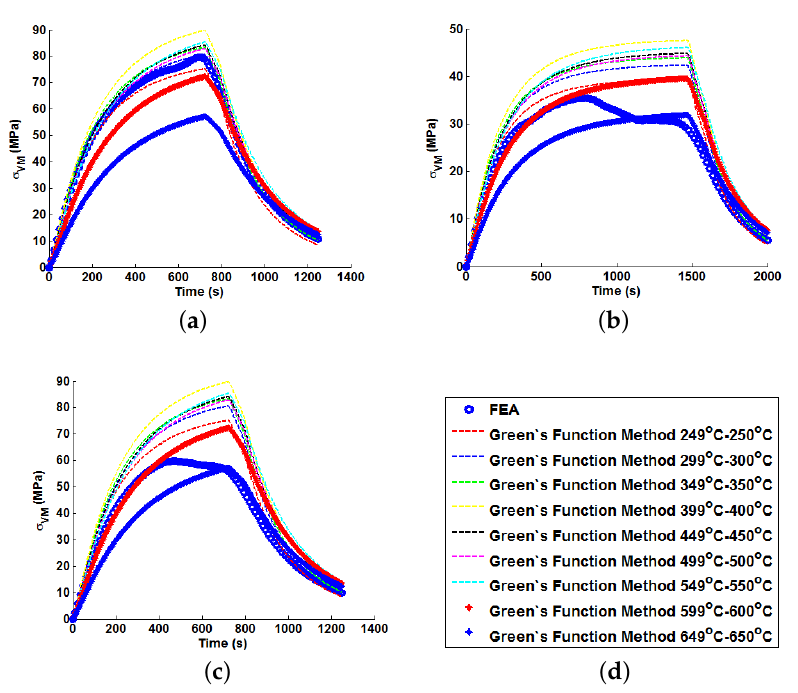
Figure 9. Predictions of thermal stress responses determined using individual Green’s functions for: ( a ) ramp up Profile D; ( b ) ramp up Profile E; and ( c ) ramp up Profile F. Sub figure ( d ) shows the legend used in the